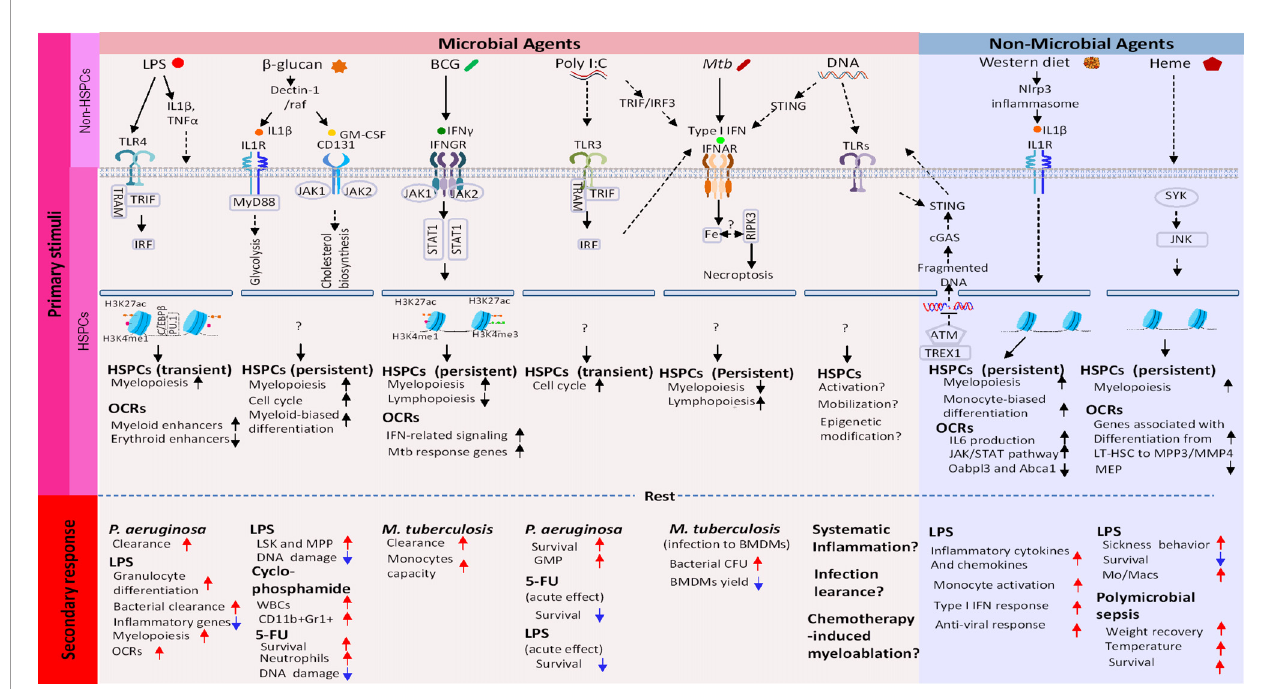
FIGURE 1 | Molecular cascades that create epigenetic memory in HSCs. Top row: Microbial Training Agents and Non-Microbial Training Agents recognized by PRRs and other sensors. Images underneath are subsequent events occurring in descending order. (1): Activation of signaling pathway involving transcription factors and kinases. (2): This then globally alters chromatin accessibility, which leads to building new transcriptome pro fi les. Open chromatin regions (OCR) can persist longer than transcriptome changes, providing a basis of lasting epigenetic marks. Shown in the bottom two rows are (3): Duration of memory and (4): Phenotypic manifestation of memory. In all cases, HSC memory acquisition involves exit from quiescence, proliferation, and myeloid-biased differentiation of LT-HSC and progenitor